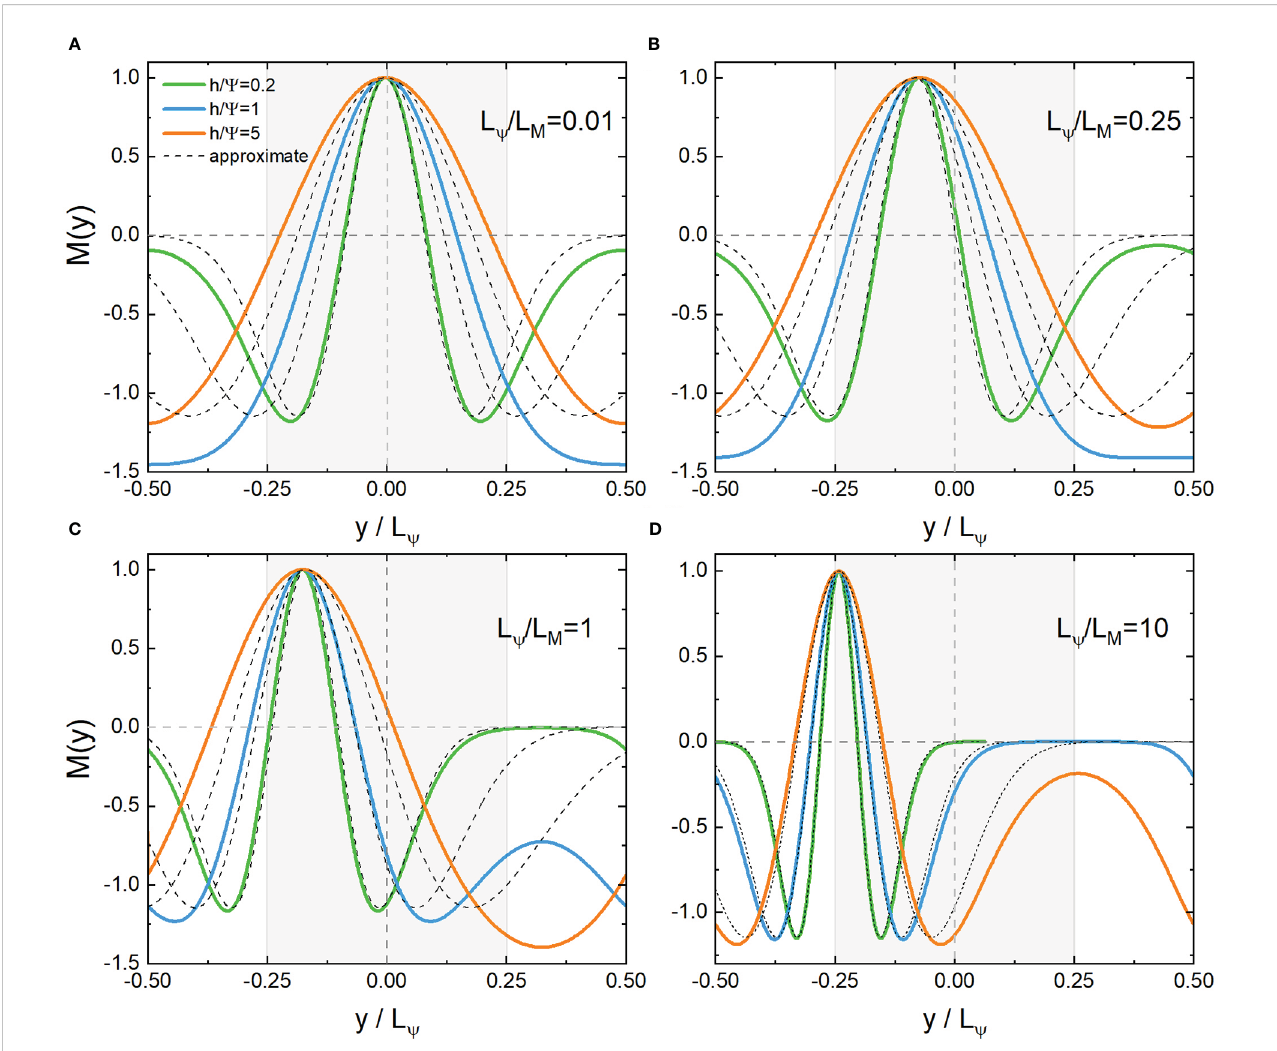
FIGURE 3 Distribution of the even eigenfunction M C ( w ′ , x , y ′ ) and its approximate solution near the core ( y =0) (A, B) or boundary ( y / L Y = − 1/4) (C, D) with the second lowest eigenvalues. L y / L M = k x / k 0 =0.01,0.25,1,10, h = Y =